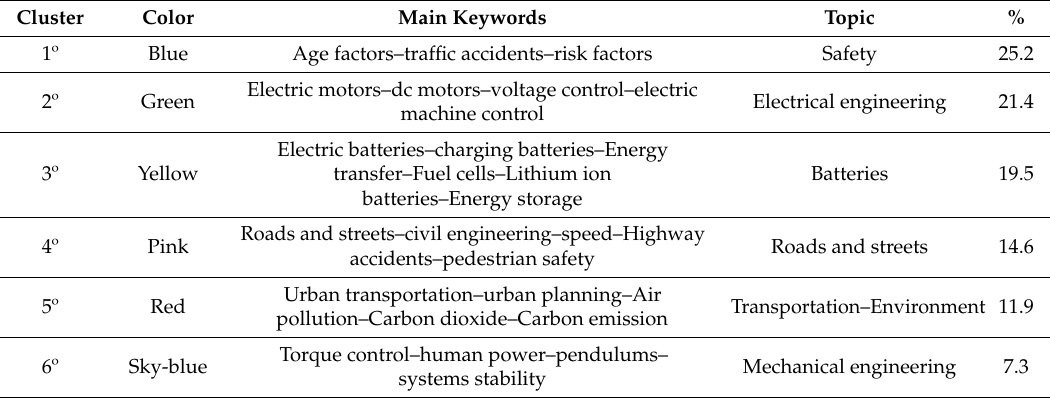
Table 3. Main keywords used by the communities detected in the topic electric